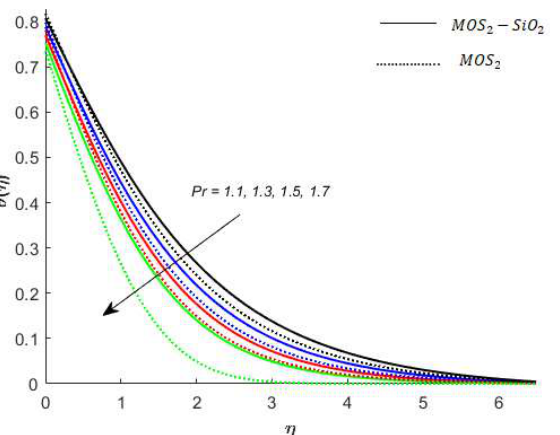
Figure 12. Variation in temperature for 𝑃𝑟 when 𝑀 = 0.2,𝑆𝑟 = 0.1,𝑆𝑐 = 0.8, (𝐺𝑟) (cid:3030) = 0.1, 𝐾 = 0.1,and 𝛽 ∗ = 0.1 .